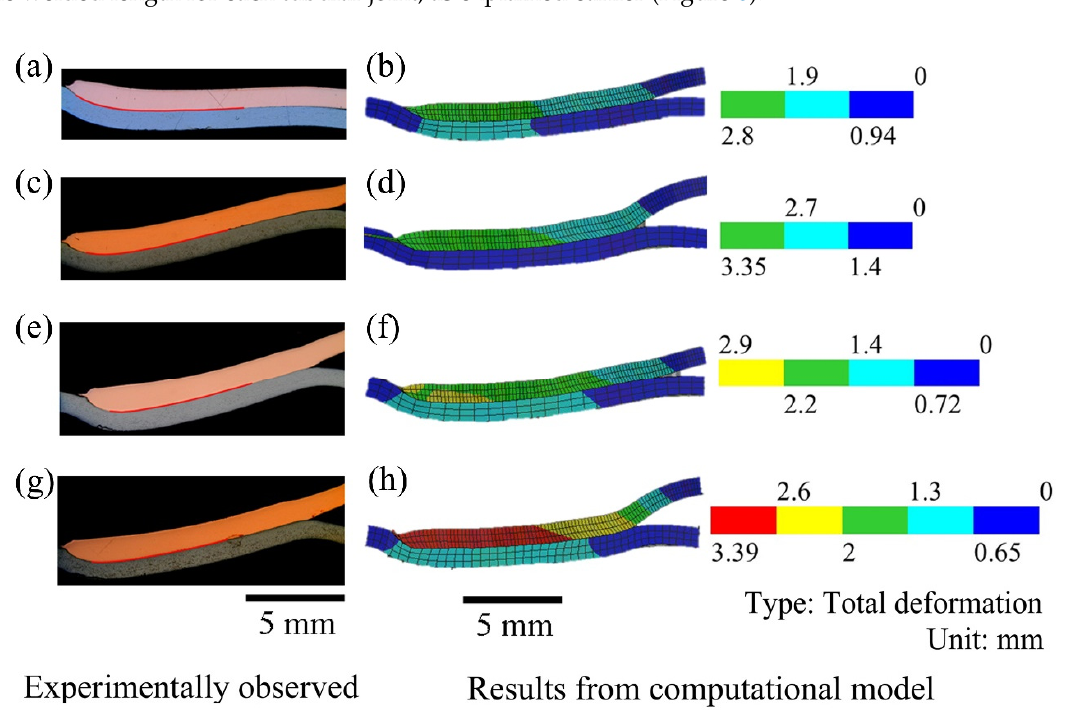
Figure 11. Experimentally observed and computationally evaluated flyer-target joint cross-sections for a discharge energy of 14 kJ ( a – d ) and 16 kJ ( e – h ), with a polyurethane internal support inside the target tube. (Initial conditions: flyer-target standoff distance = 1 mm ( a , b , e , f ) and 2 mm ( c , d , g , h ); flyer tube: diameter = 22.22 mm, wall thicknesses = 0.89 mm; target tube: wall thicknesses = 1 mm; diameter = 18.44 mm (standoff distance = 1 mm), 16.44 mm (standoff distance = 2 mm)).